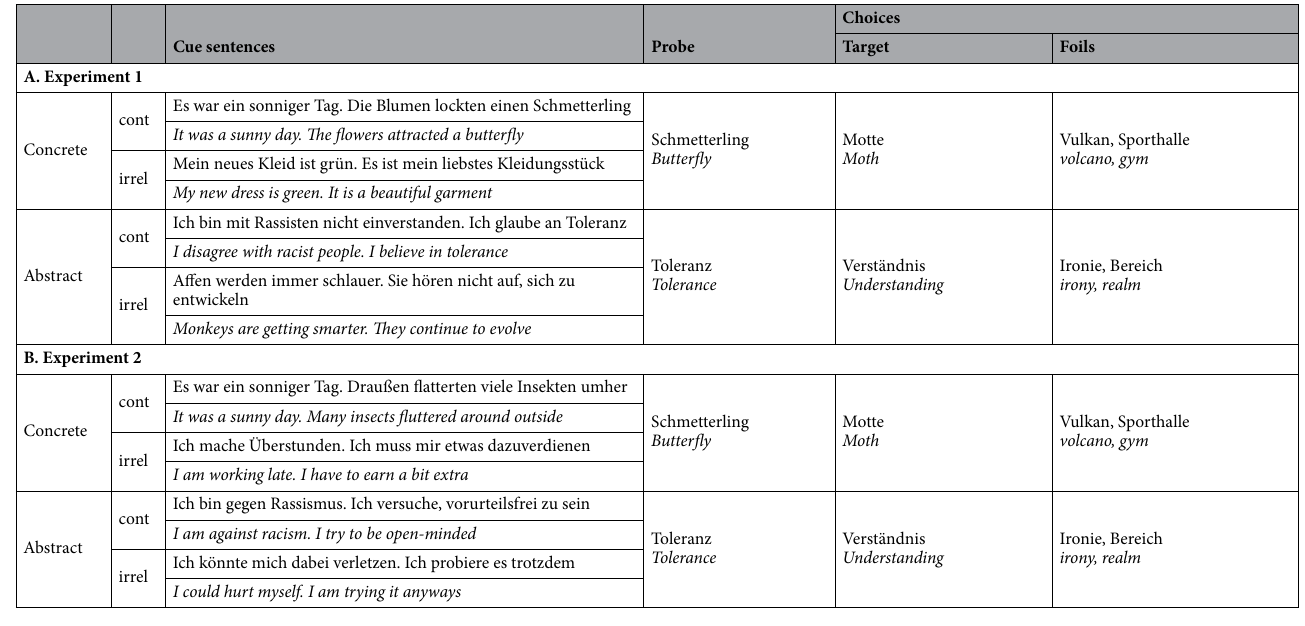
Table 1. Example stimuli used in Experiment 1 (A) and Experiment 2 (B). Example stimuli (original in German, with English translation ) for one concrete and one abstract probe in the contextual (cont) and irrelevant (irrel) cue